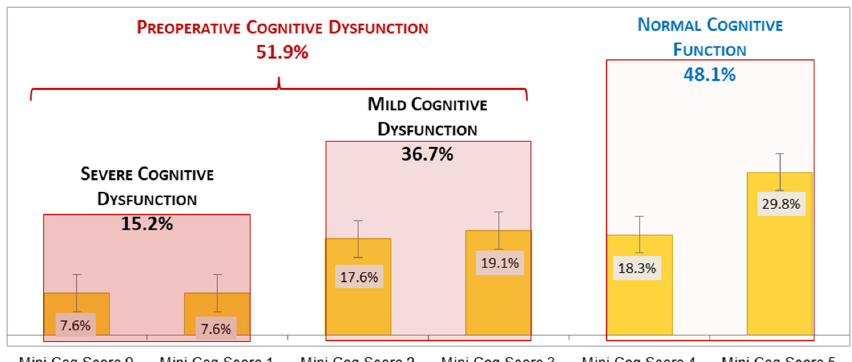
Figure 2. Preoperative cognitive function in elderly cancer patients.